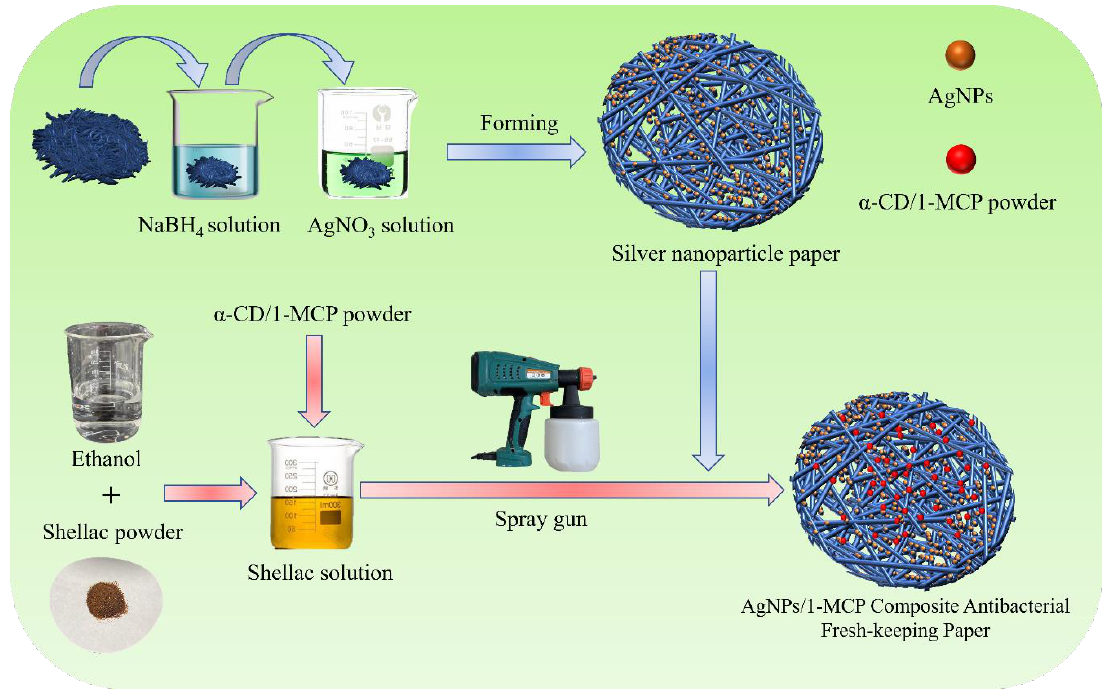
Figure 1. Preparation process of AgNPs/1-MCP antibacterial fresh-keeping composite paper.